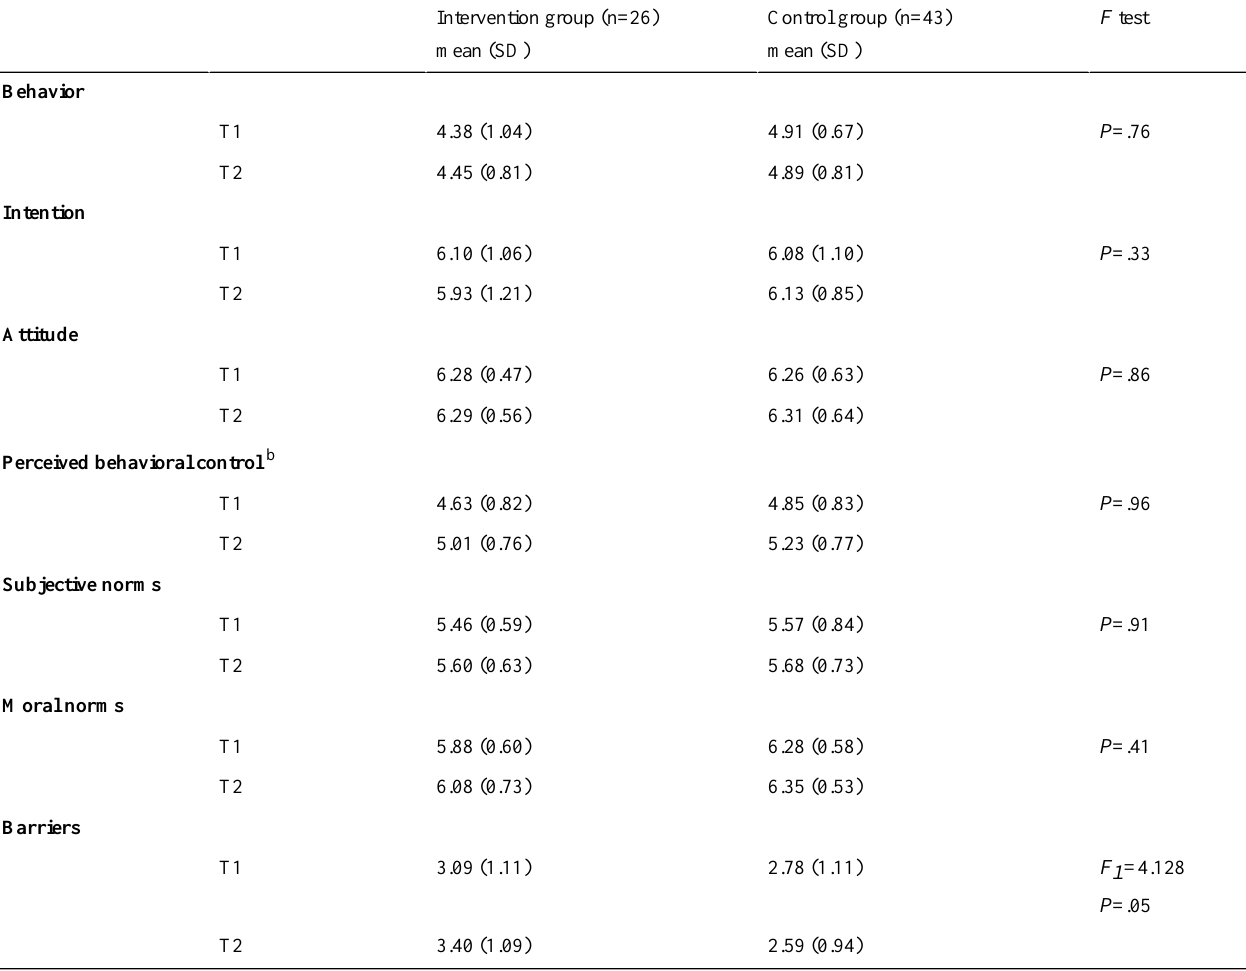
Table 3. Differences between narrowed intervention group and control group, measured at T1 and T2. a